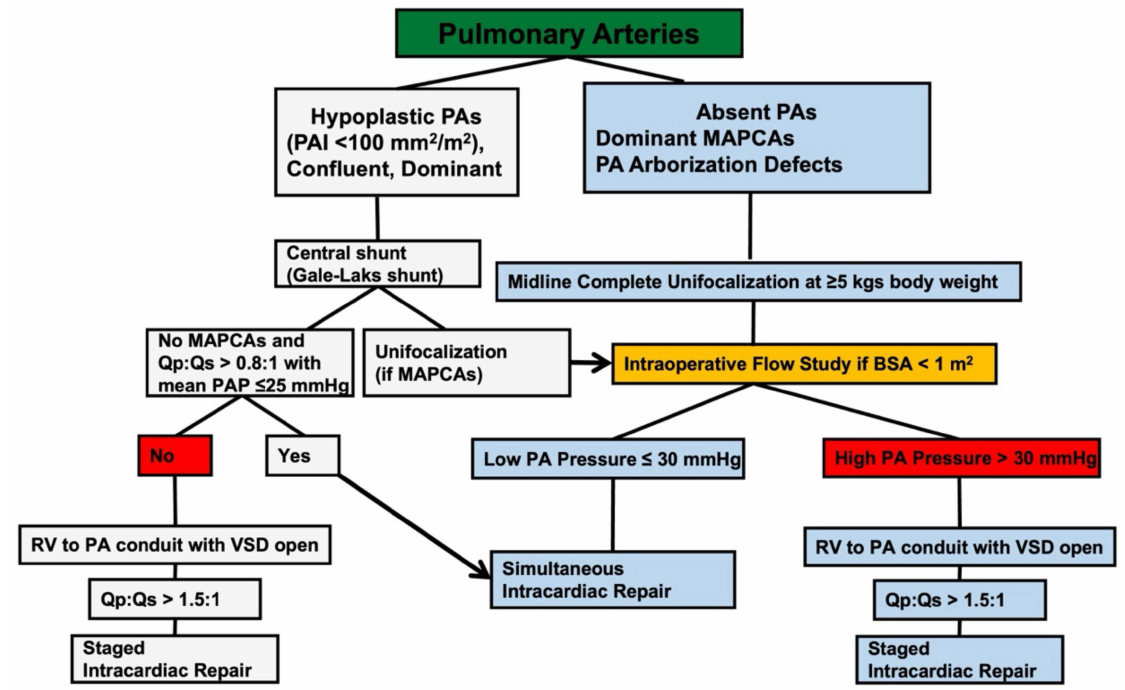
Figure 1. Childrens’ Hospital Bambino Ges ù algorithm for PA/VSD/MAPCAs treatment in infancy according to the presence, size and distribution of native pulmonary